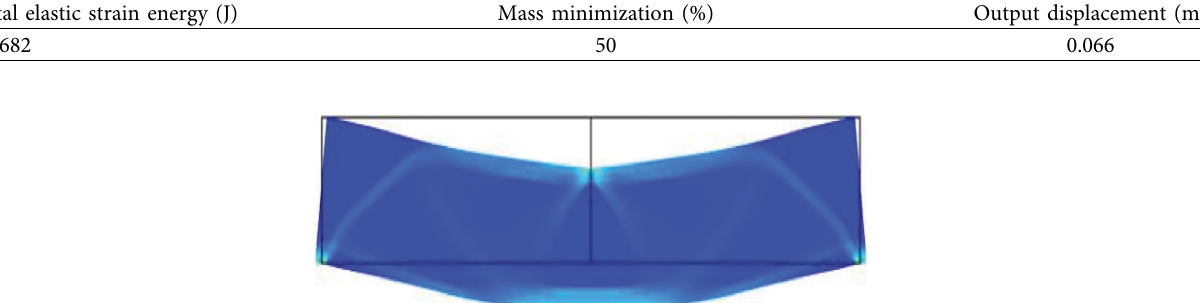
Figure 3: Stress distribution after multiple iterations.